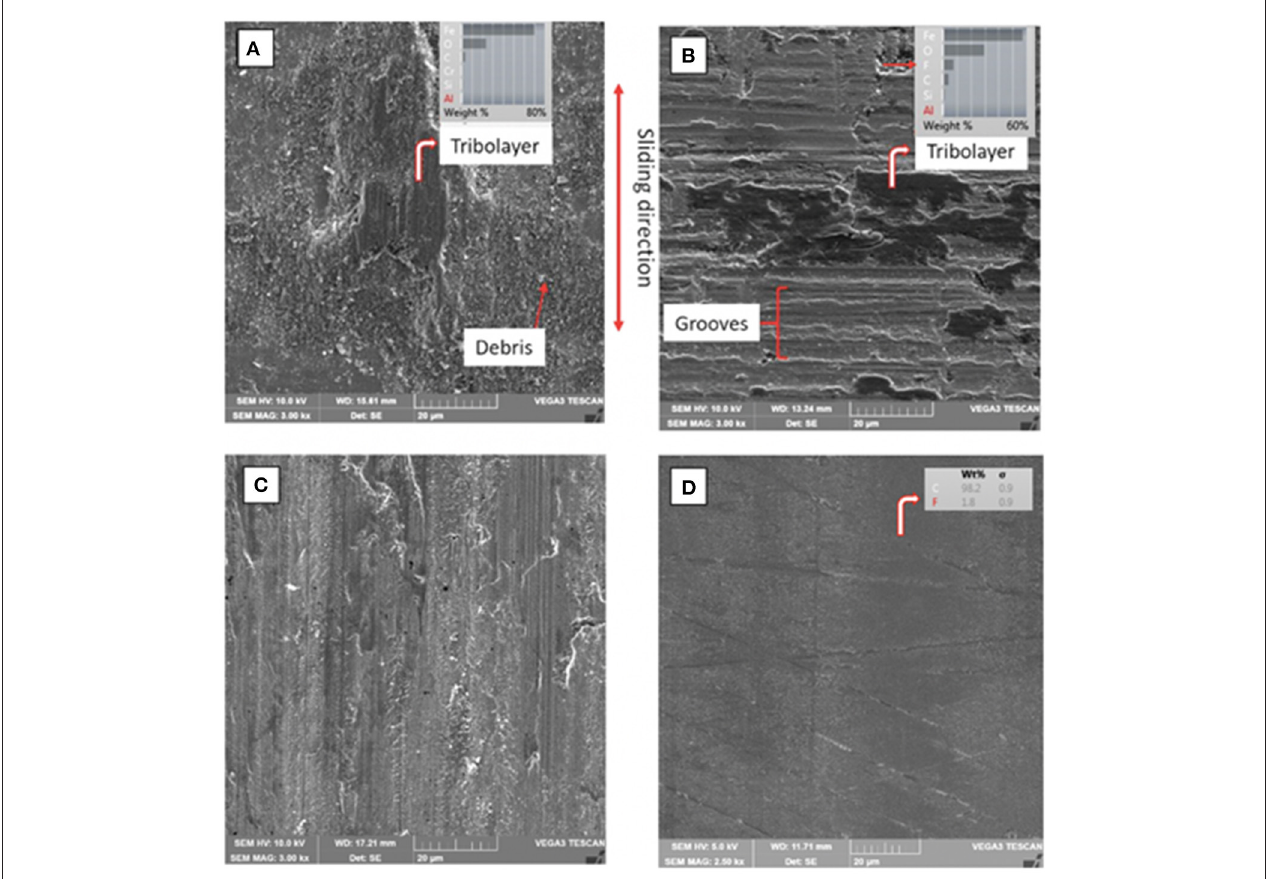
FIGURE 12 | Typical SEM images of the tested areas of the (A) cylinders under refrigerant gas. (B) Cylinders under ambient air. (C) DLC piston under ambient air. (D) DLC piston under refrigerant gas. The inserts are a summary of the analysis by EDS.